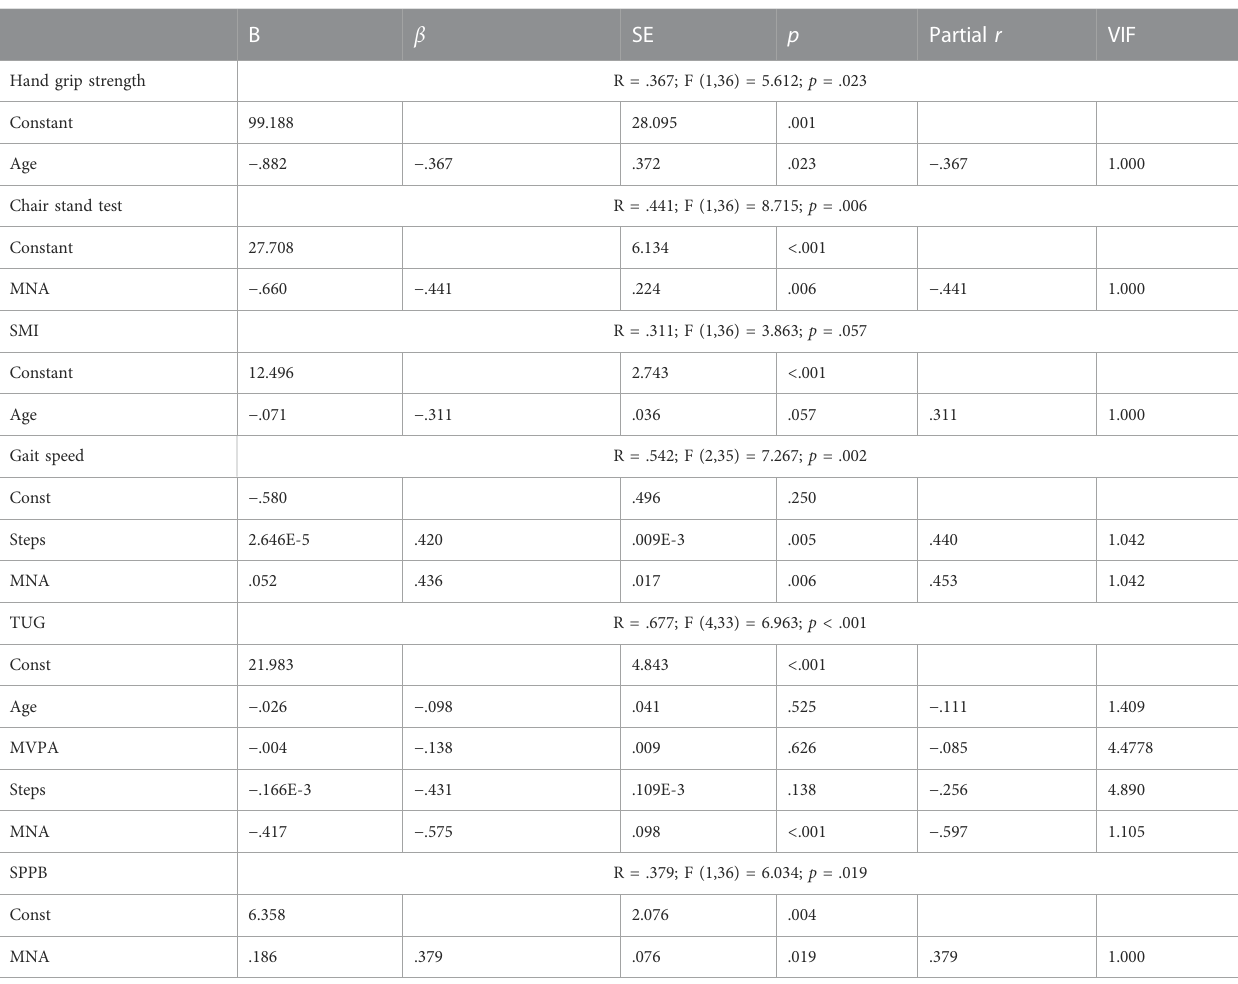
TABLE 4 Multiple linear regression analysis of the effect of age, physical activity, number of daily steps and nutritional status on sarcopenia parameters. B β